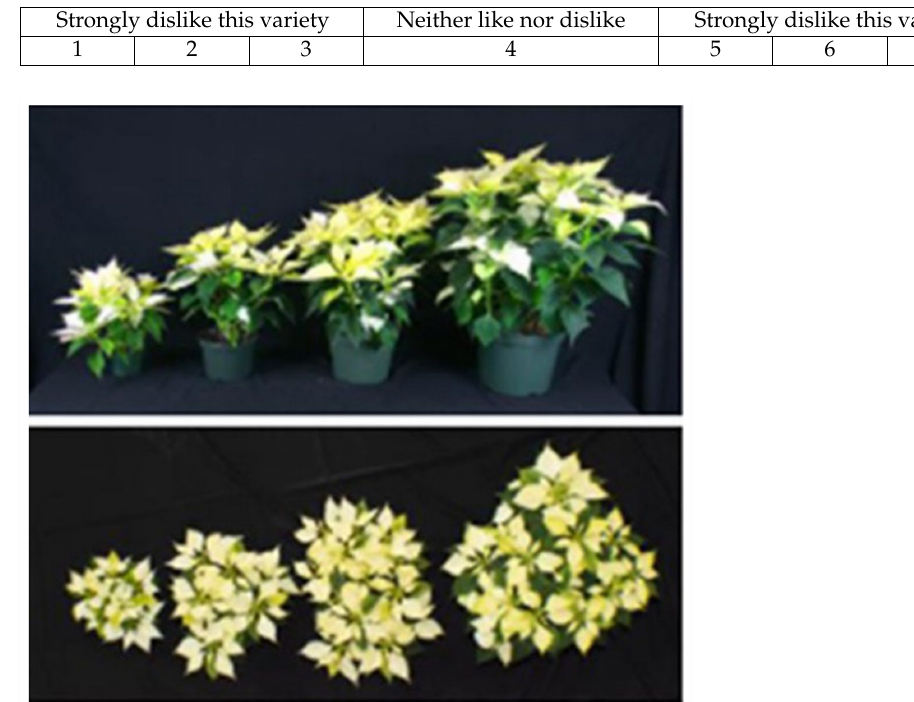
Figure 2. Top and side views of a poinsettia cultivar in four pot sizes included in the willingness-to- pay